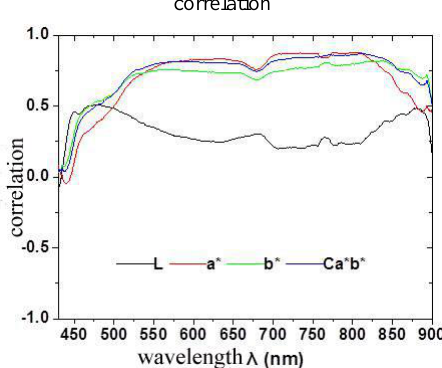
Figure 2. reflectance and various degrees of correlation